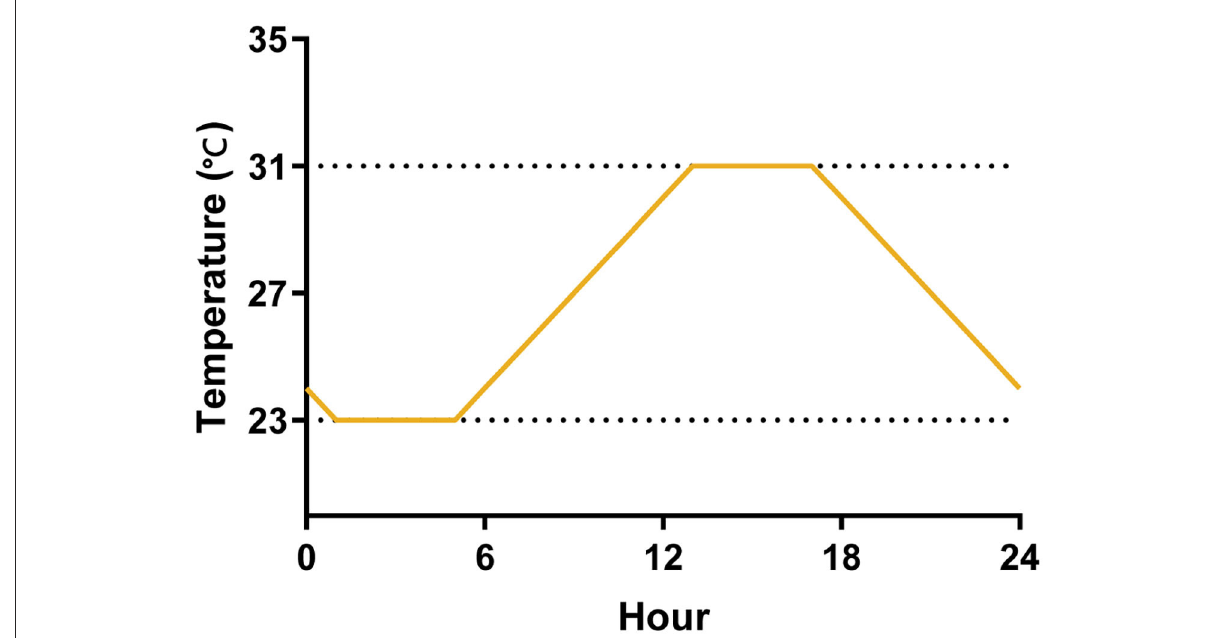
FIGURE1 A diagram of the temperature fluctuations of DTR for 1 day. The temperature was maintained at 23 ◦ C from 1:00 to 5:00, and gradually increased from 23 to 31 ◦ C from 5:00 to 13:00, then it was maintained at 31 ◦ C until 17:00, and finally dropped to 23 ◦ C from 17:00 to